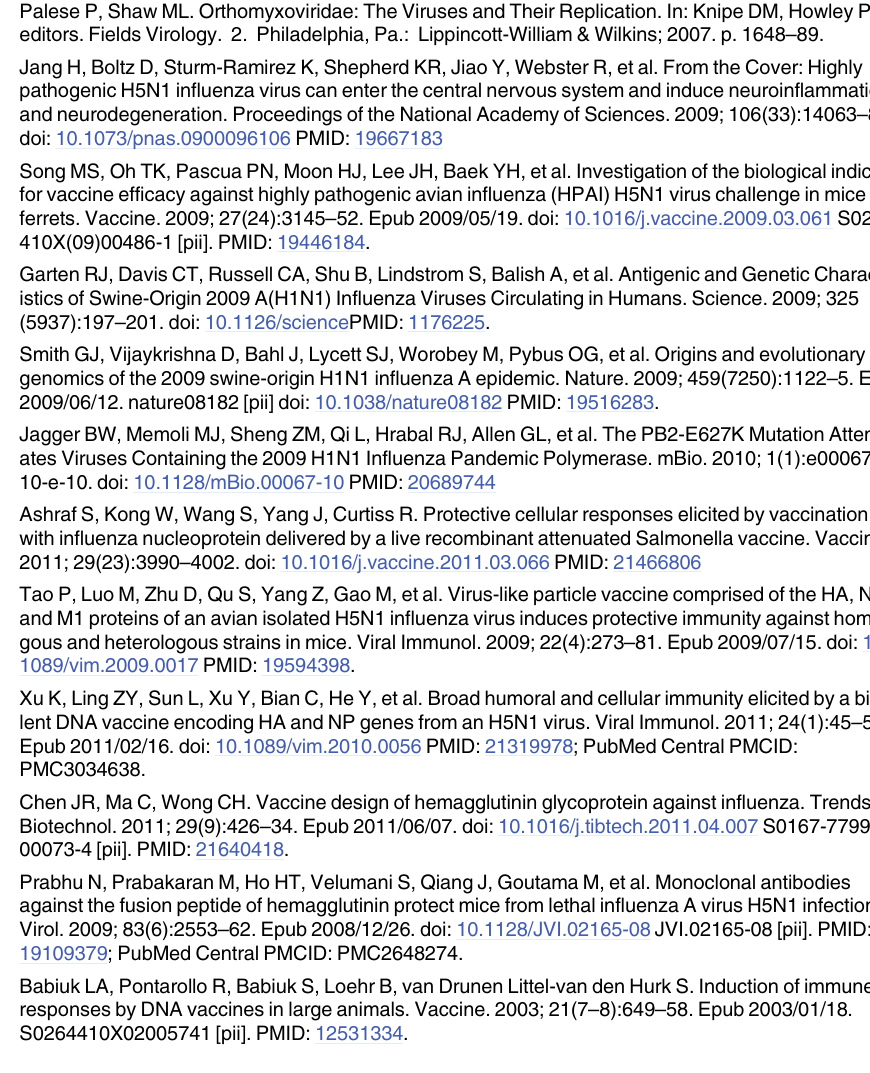
S2 Table. Vaccines used in the